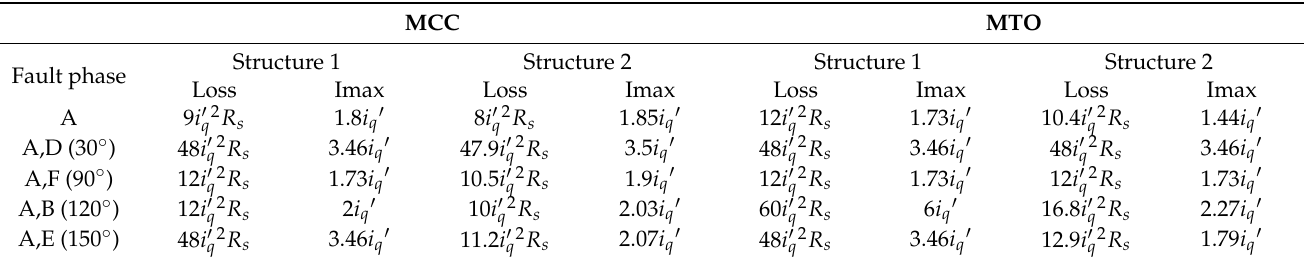
Table 1. Fault-tolerant control of DTP-PMSM in single-phase and two-phase open circuits with two current optimization